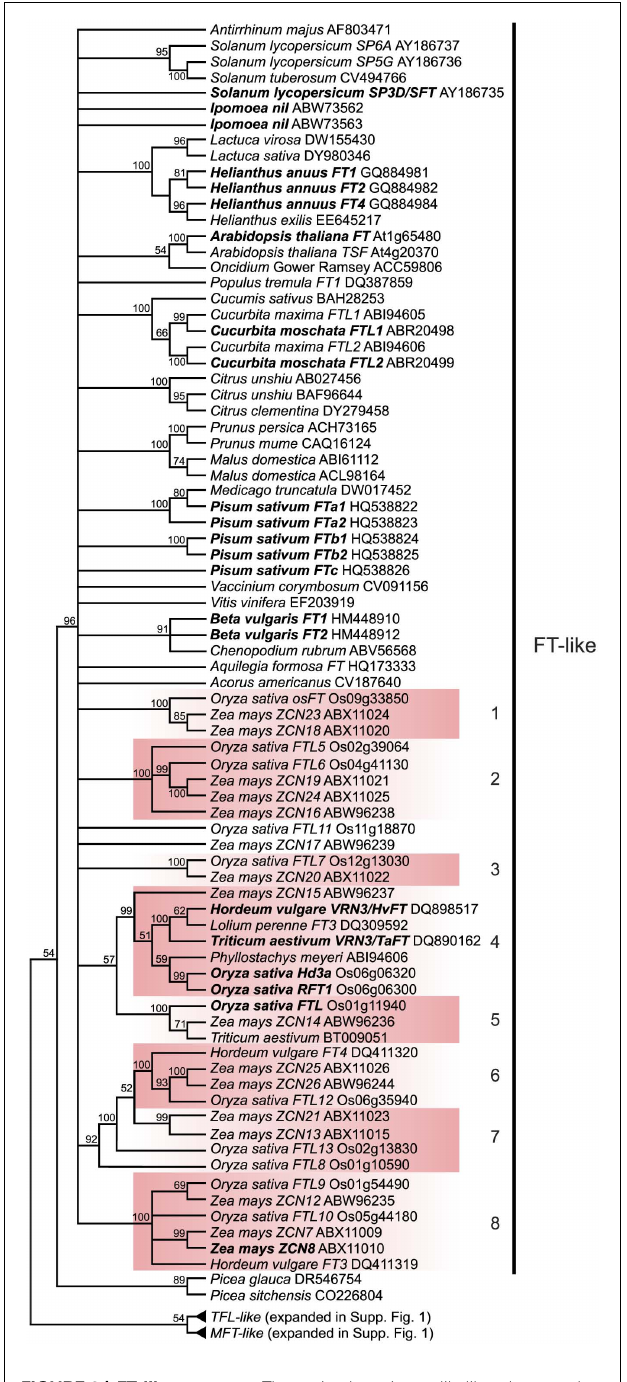
FIGURE 2 | FT -like gene tree. The optimal maximum likelihood tree and bootstrap percentages (shown above branches) were inferred from analyses of full-length nucleotide sequences using RAxML 7.0.4 (Stamatakis, 2006). All nodes with less than 50% bootstrap support have been collapsed.The FT clade shown here has been rooted with the MFT and TFL lineages (see FigureA1 in Appendix for complete phylogeny).The many duplications within grass lineages in the FT-like family are highlighted by the colored boxes and associated numbers. Genes in bold text are specifically discussed in the text. GenBank or EMBL accession numbers are provided for each